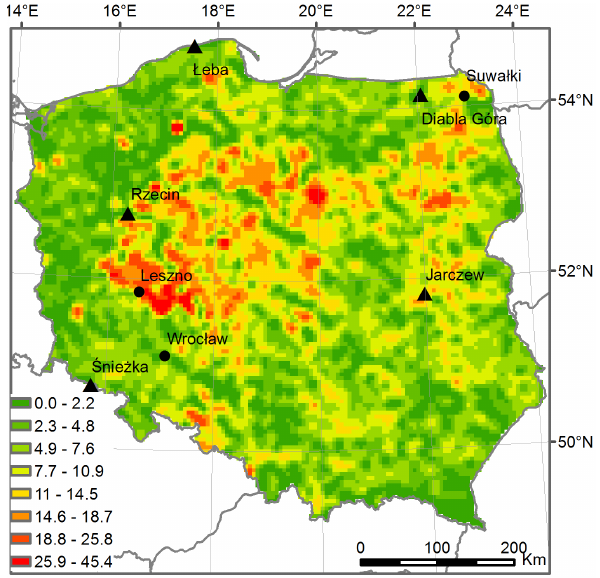
Figure 1. Total annual emission of NH 3 in 2010 [kgha − 1 yr − 1 ]. NH 3 measurement sites indicated by triangles. Additional loca- tions discussed in the paper indicated by dots (Wrocław, Leszno,